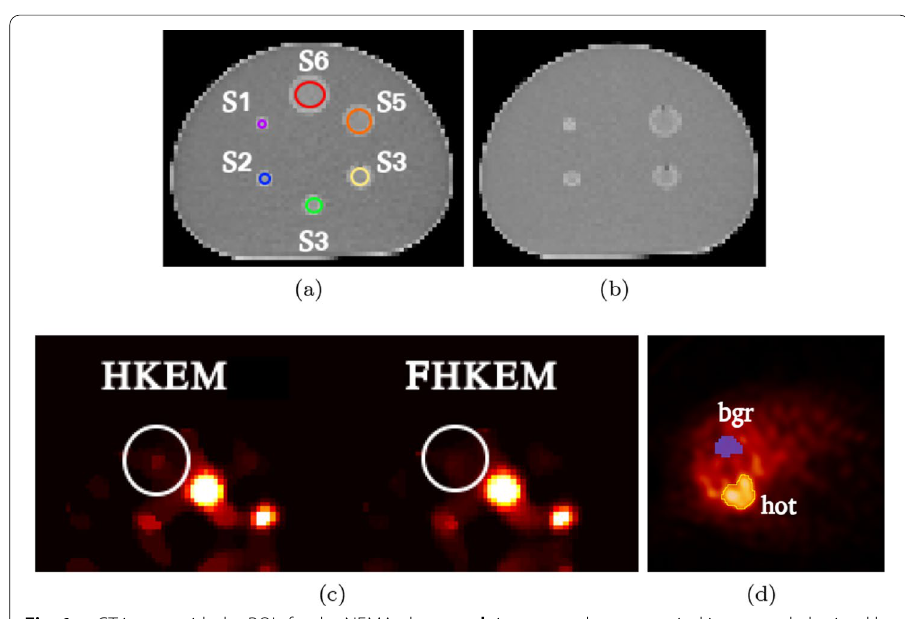
Fig. 1 a CT image with the ROIs for the NEMA phantom; b image used as anatomical image and obtained by removing the spheres S6 and S3 from the CT in 1a; c Magnification of the SPECT reconstructed images with HKEM and FHKEM for the NEMA phantom. The image is zoomed in on the phantom area containing spheres S1, S5 and S6. Within the white circle is shown a false small region of activity in the HKEM image which is not shown in FHKEM. d Background (bgr) and hot ROIs example for the patient data using FHKEM. All The images show the transaxial